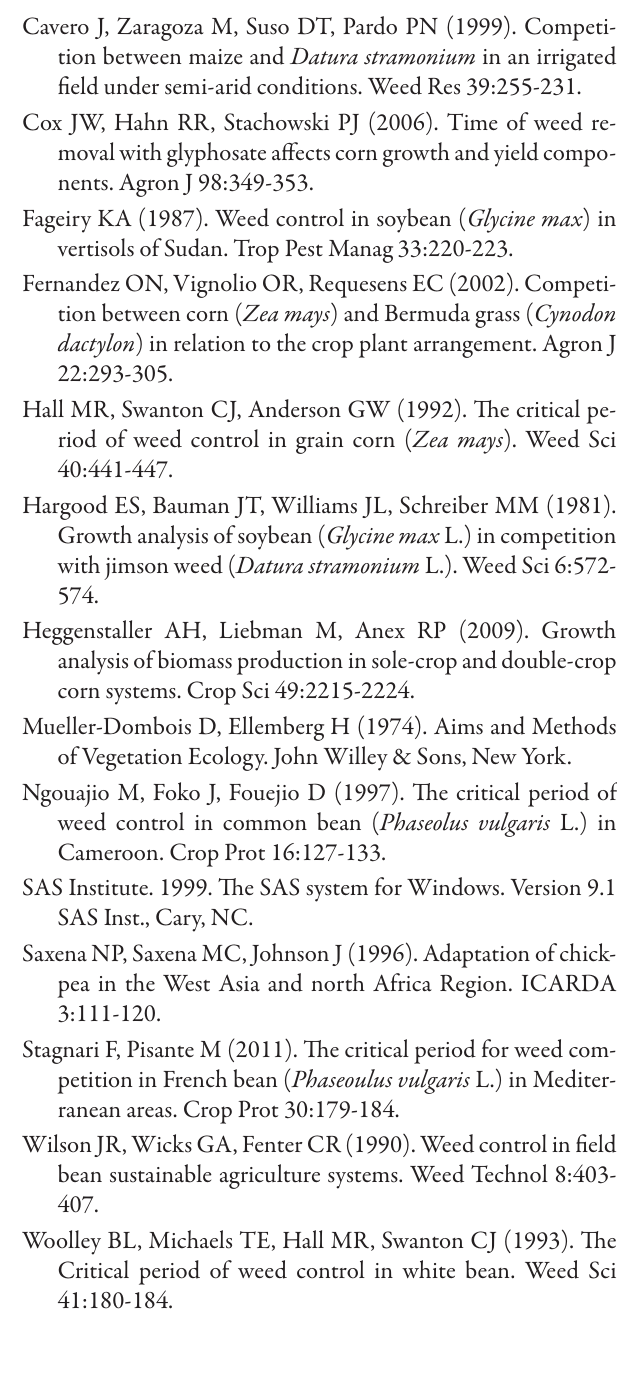
of branches, pods number and grain yield was